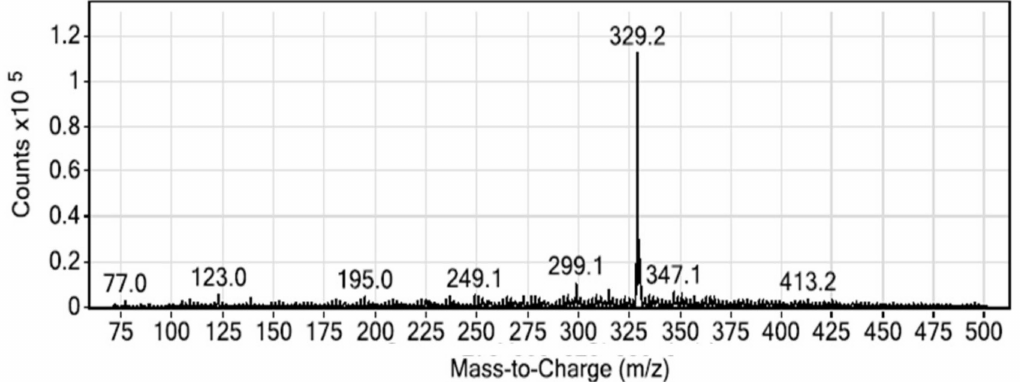
Figure 1. Full ion spectra of malachite green in positive ionization mode.